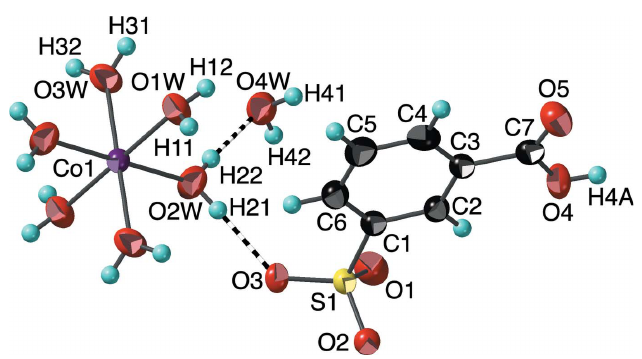
Figure 2 The molecular structure of (II), showing the atom-numbering scheme. Displacement ellipsoids are shown at the 90% probability level and hydrogen atoms are shown as small spheres of arbitrary radii. Hydrogen bonds are shown as striped cylinders. Symmetry-equivalent oxygen atoms are included to show the complete coordination environment of the cation.